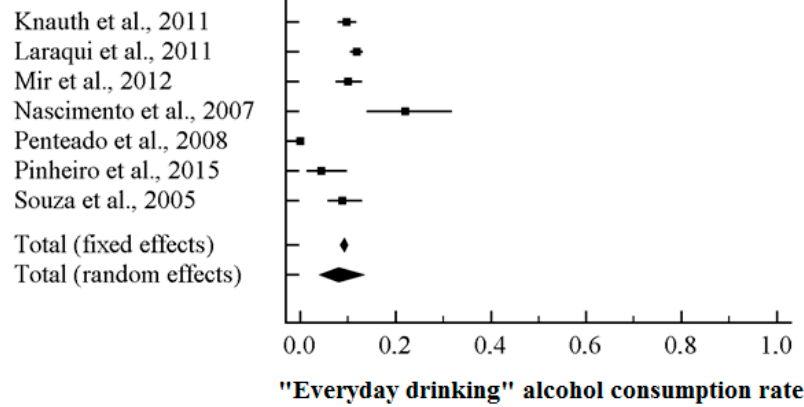
Figure 6. Forest plot for “everyday drinking” consumption rate among truck-drivers. Int. J. Environ. Res. Public Health 2018, 15, x FOR PEER REVIEW